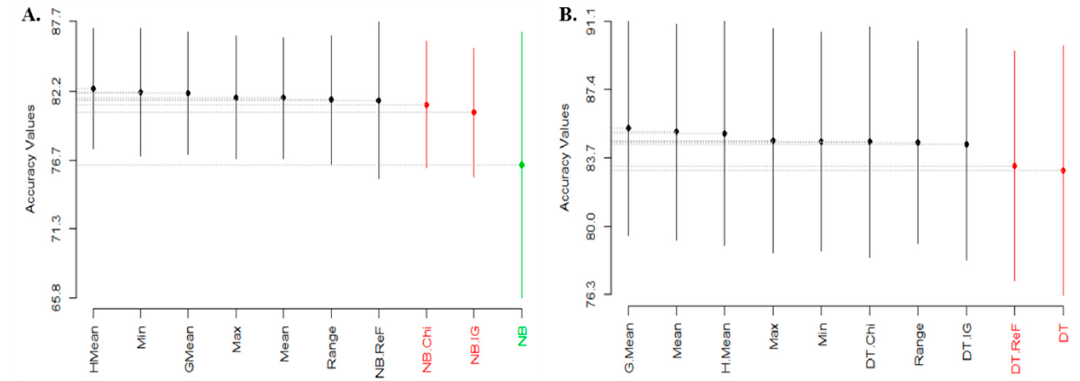
Figure 5. Scott-Knott Rank Test Result of FS methods on NB and DT classifier models based on average Accuracy values. ( A ) Average accuracy values of NB; ( B ) Average accuracy values of DT.